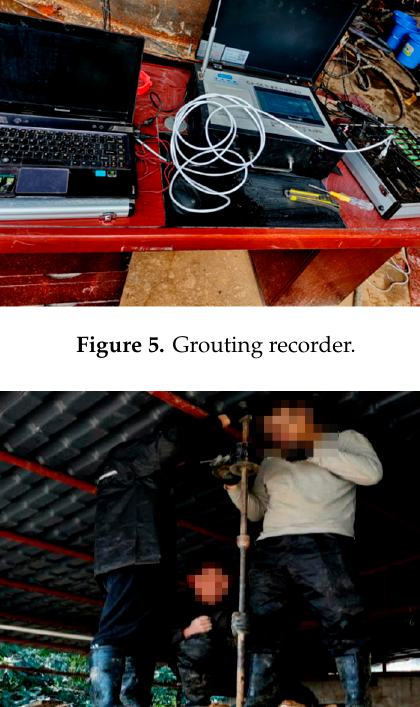
Table 1. Basic physical-mechanical parameters of the soil.